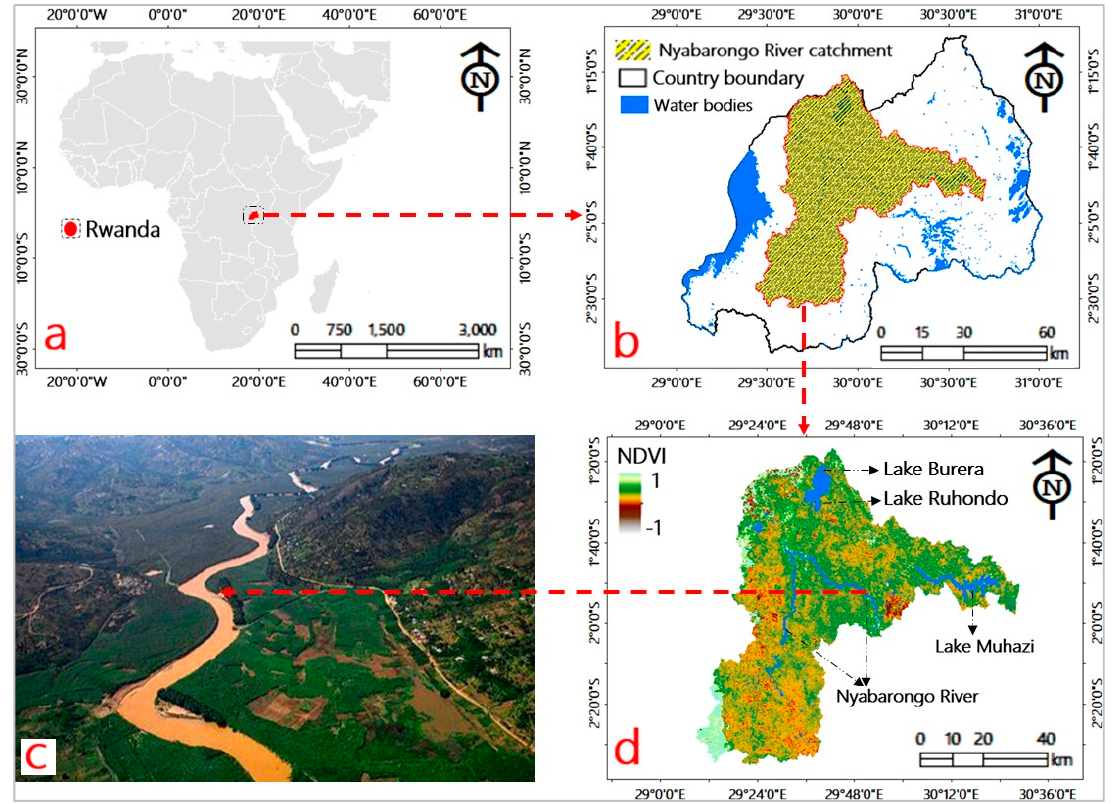
Figure 1. Geographical location map of the Nyabarongo River catchment; ( a ) Location at the continent level; ( b ) Location at the country level; ( c ) An aerial outlook of the Nyabarongo River [51]; ( d ) Normalized difference vegetation index of the catchment with the Nyabarongo River and lakes.